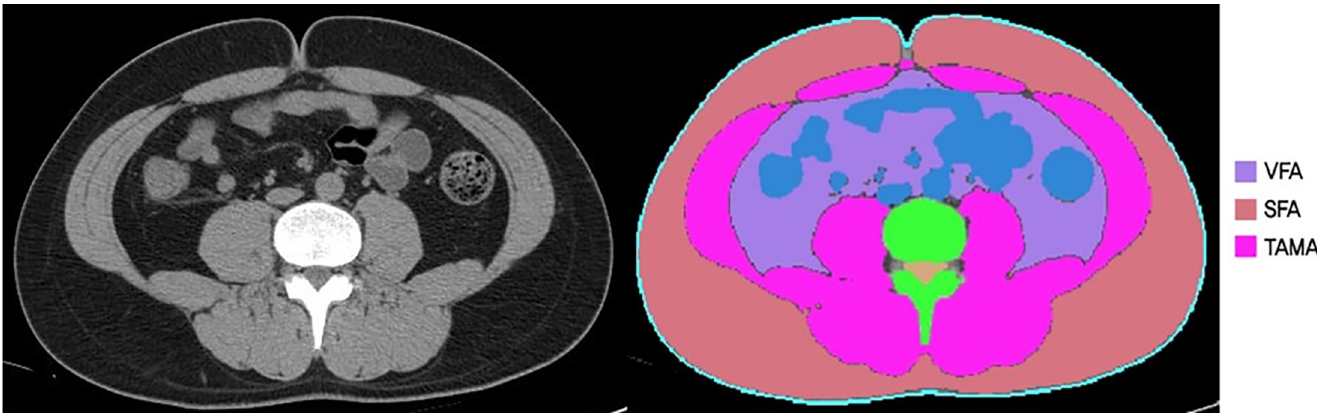
Fig 2. Body morphometric evaluations of abdominal fat and muscle areas. At the level of the inferior endplate of the L3 vertebra, a segmented axial computed tomography image showed the visceral fat area (VFA, cm 2 ), subcutaneous fat area (SFA, cm 2 ), and total abdominal muscle area (TAMA, cm 2 ), including all muscles on selected axial images (psoas, paraspinals, transversus abdominis, rectus abdominis, quadratus lumborum, and internal and external obliques).